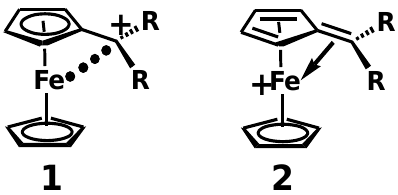
Figure 1. Delocalization of charge from the cationic α carbon onto the iron atom.